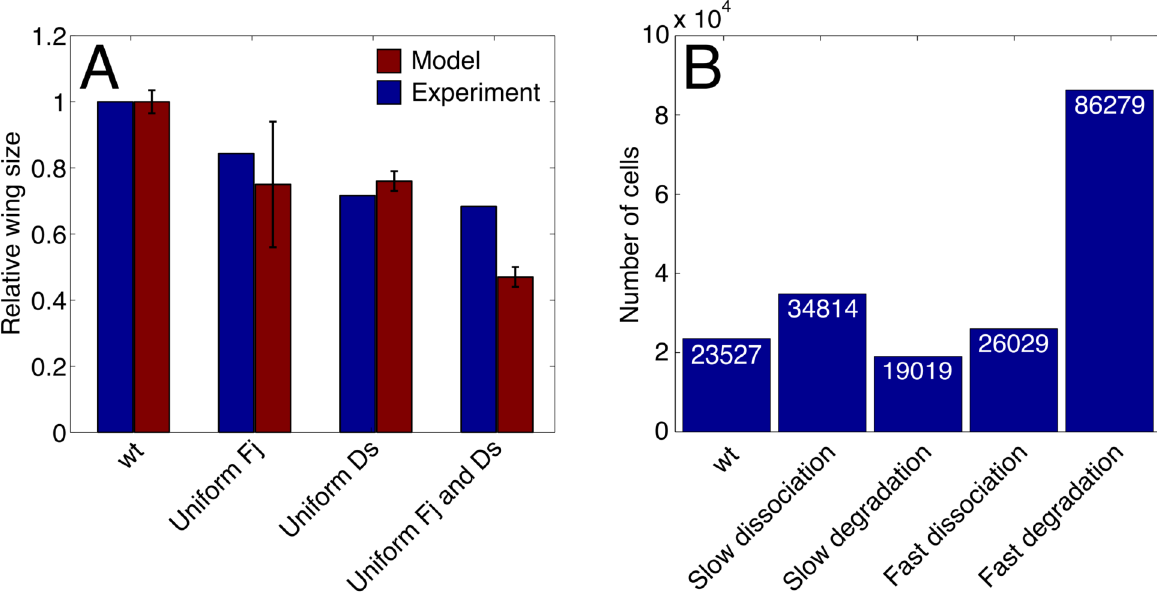
Fig 6. The number of cells in the wing disc under various conditions and parameter values. In each case, the same starting set (in terms of cell sizes and locations)of 1000 cells was simulatedfor 2880 time steps, correspondingto 48 hours of real time, the approximate length of the third instar. (A) Each bar marked “Model” represents the relative size of the disc compared to wild-type(the numberof cells in that disc dividedby the numberof cells in the wild-type disc) averagedover 20 runs with the same conditions. (Becausethe size at which a cell dividedand the rates at which it formed and dissolvedFt-Ds bondswere not completelydeterministic as describedin Section 4 of the Supplemental Text, simulationruns under the same conditionswere not identical.) These relative sizes were compared to the correspondingexperimental results (red bars) on the sizes of adult wings relativeto the size of the wild-typewing [7]. Here, “uniform Fj”, “uniform Ds”, and “uniform Fj and Ds” are discs that uniformly express high levels of Fj, Ds, or both. Other than the stated variations, each run used the same set of parameter values as describedin Section 10 of the Supplemental Text. The error bars on the simulationresults are less than 1% of the heightof the bars shown in the plot and therefore are not shown. The error bars on the experimental results correspondto one standard deviation. (B) The number of cells in the wing disc using different parameter values. As in panel A, the same set of 1000 cells was simulatedfor 2880 time steps, or 48 hours. Each bar representsthe averagenumberof cells in the disc over 20 of these runs. In “slow dissociation”, the dissociationrate of Ft-Ds bondswas decreasedby a factor of 10 to 8x10-3 per time step (from the wild-type value of 0.08 per time step). In “slow degradation”, the degradation rate of free Ft and Ds was decreased by a factor of 10 to 8x10-3 per time step (from the wild-typevalue of 0.08 per time step). Similarly, in “fast dissociation”, the dissociationrate of Ft-Ds bonds was increasedby a factor of 10 to 0.8 per time step. In “fast degradation”, the degradation rate of free Ft and Ds was increasedby a factor of 10 to 0.8 per time step. As in panel A, each run used the same (wild-type)set of parameter values other than the stated